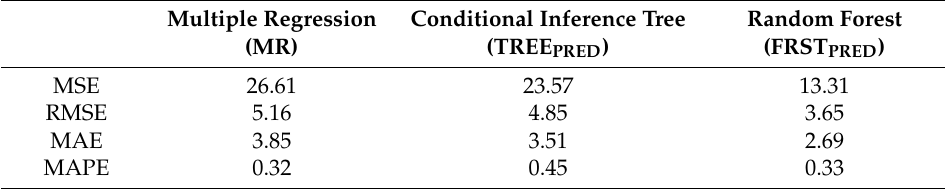
Figure 3. The Bland–Altman bias (solid line) and 95% limits of agreement (dashed lines) are presented for each of the foot strike angle (FSA) prediction methods. Green = rear foot strikes; Red = mid foot strikes; Blue = fore foot strikes; Bias = average of the residuals; Limits of agreement = ± 1.96 standard deviations around the bias. Table 3. Foot strike angle prediction model performance accuracy is